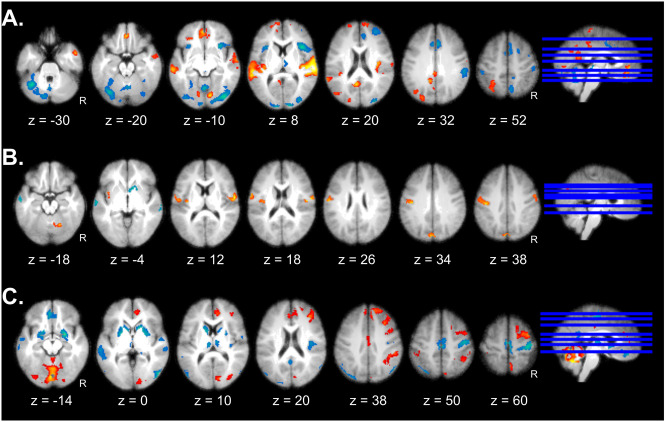
Emotion component networks.Component brain networks whose activity is modulated by Motivation (A), Expression (B), and Physiology (C). Red/orange colors reflect positive and blue colors reflect negative correlations with the respective indices. Effects are presented on axial slices of a mean image created by averaging the participants’ normalized structural images and displayed at a voxel height threshold p < 0.001 with a cluster-level threshold of pFWE < 0.05. Individual beta maps used for this figure are available on Neurovault at https://identifiers.org/neurovault.collection: 8740.